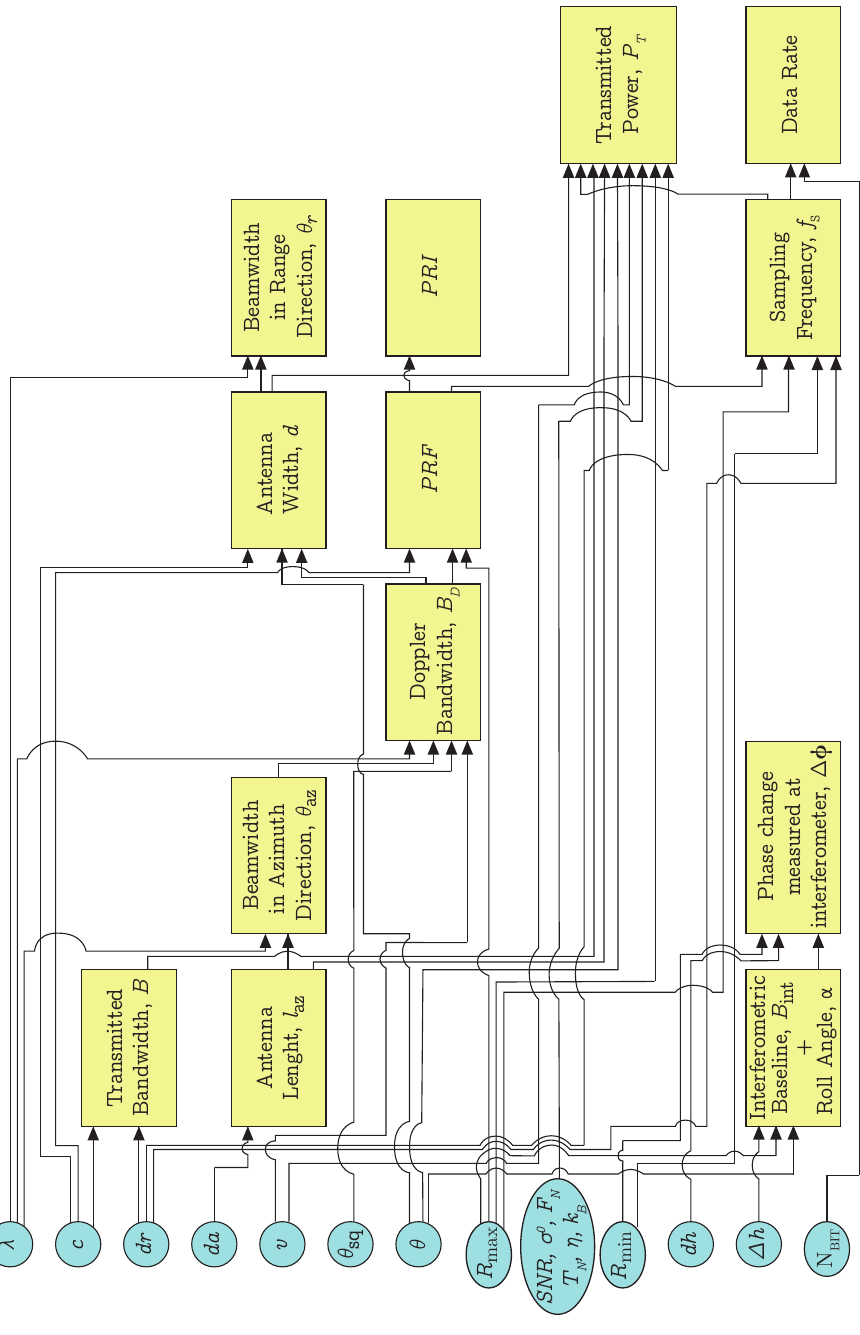
Figure 3. Design process guidelines: Block